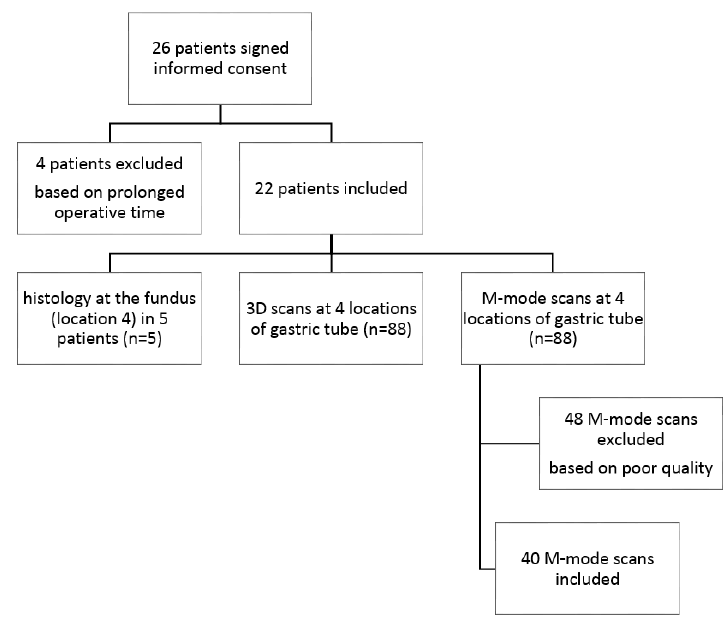
Figure 4. Flow diagram: patient and data inclusion.